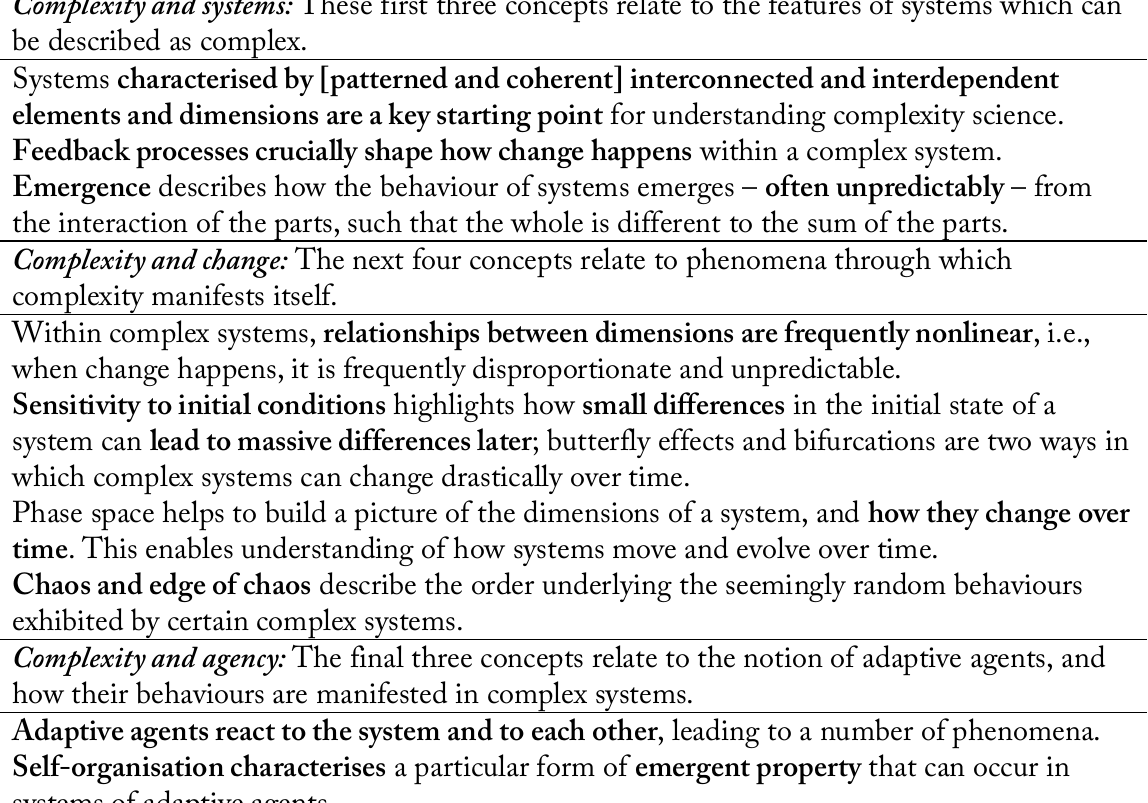
Table ii: Key concepts associated with complex adaptive